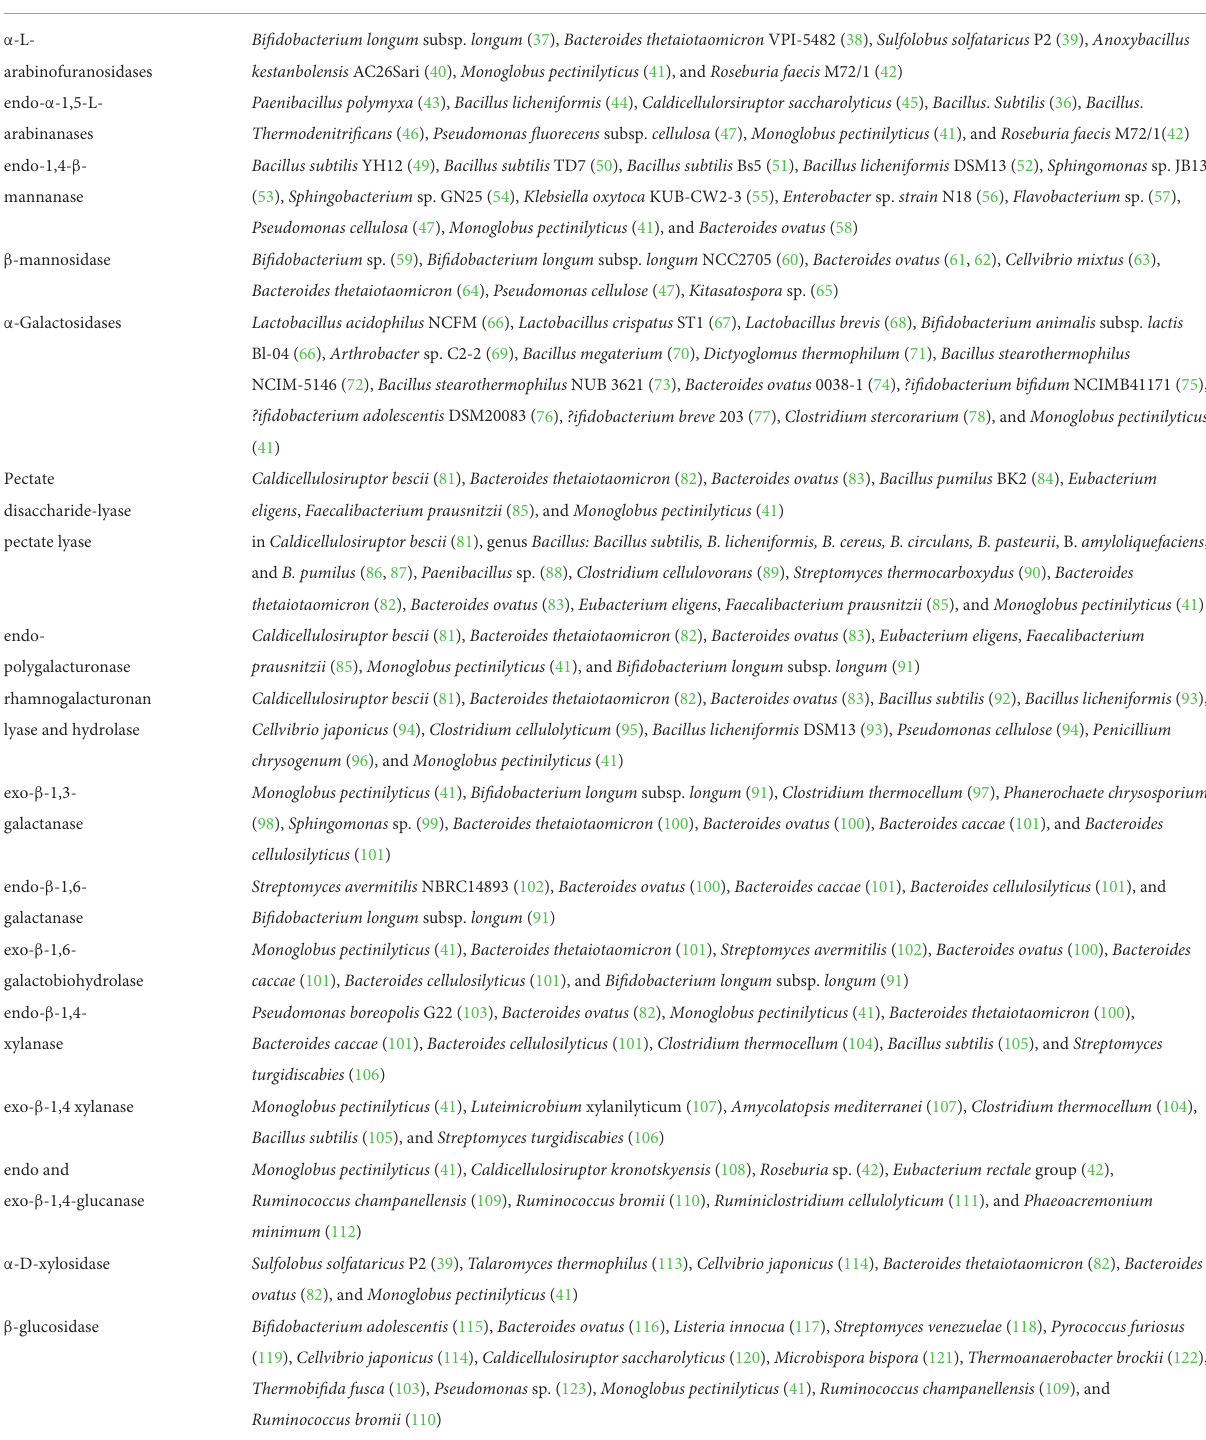
TABLE 4 Gut microbes containing the indicated plant cell wall degrading enzymes. Microbial